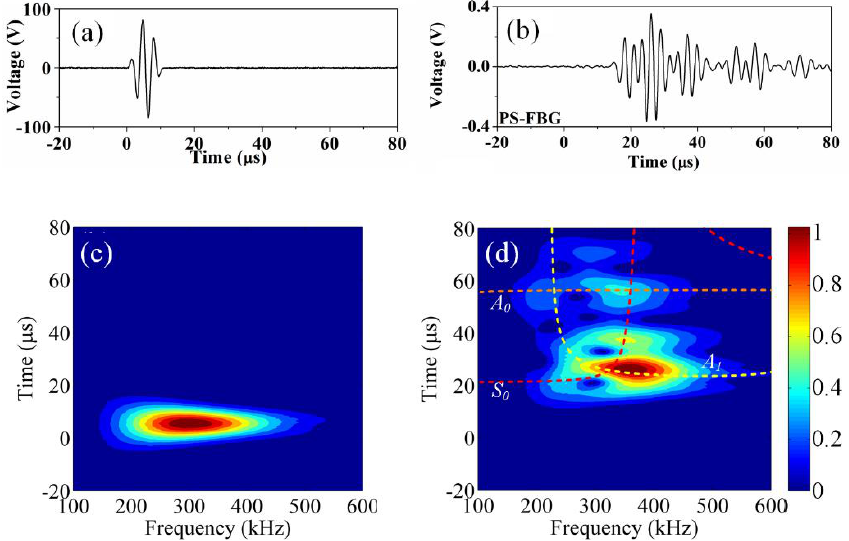
Figure 12. The typical waveform in acousto-ultrasonic detection. ( a ) input signals; ( b ) detected signals; ( c , d ) corresponding wavelet transform results. ( c , d ) corresponding wavelet transform